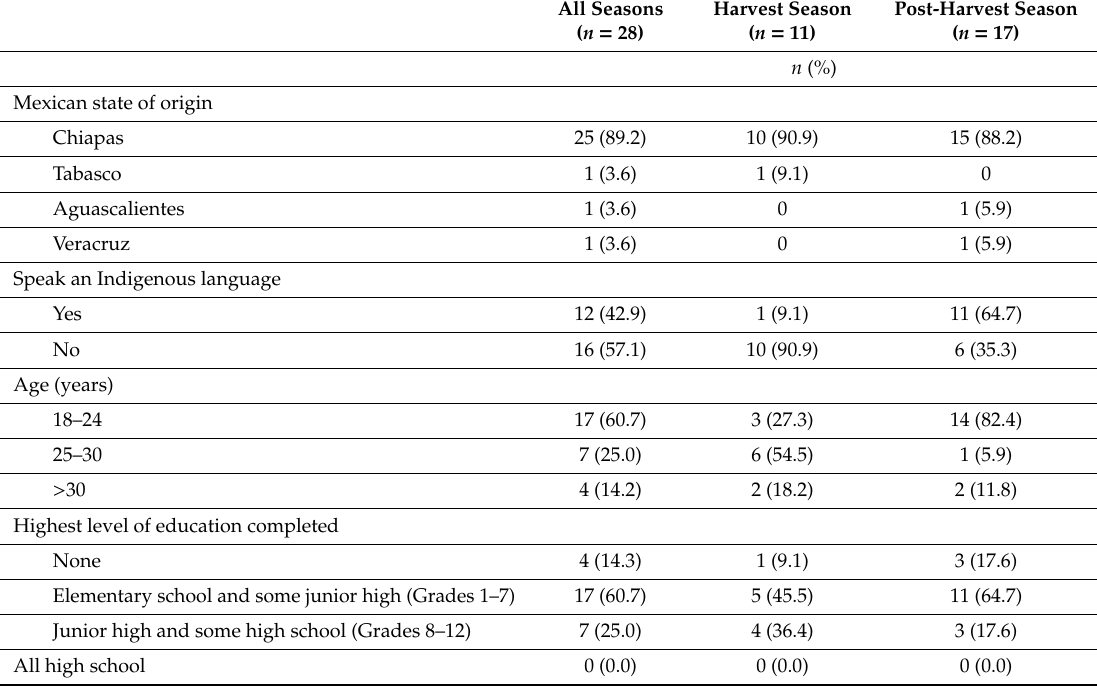
Table 1. Participant demographic information by